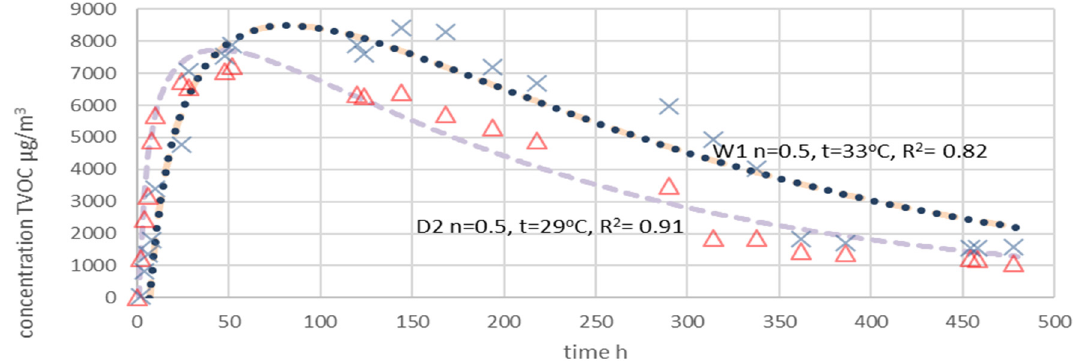
Figure 12. The TVOC emission profiles from D2 and W1 similar floor systems (tested for480 h) for the air change rates n = 0.5 h − 1 at 29 ◦ C for D1 and at 33 ◦ C for W1 (and RH = 50% for D1 and RH = 80% for W1) and polyurethane–epoxy adhesive; D2 is made of polyurethane solvent primer and polyurethane–epoxy adhesive (see Table 3); significant VOCs compounds for these products are provided in Table 1).